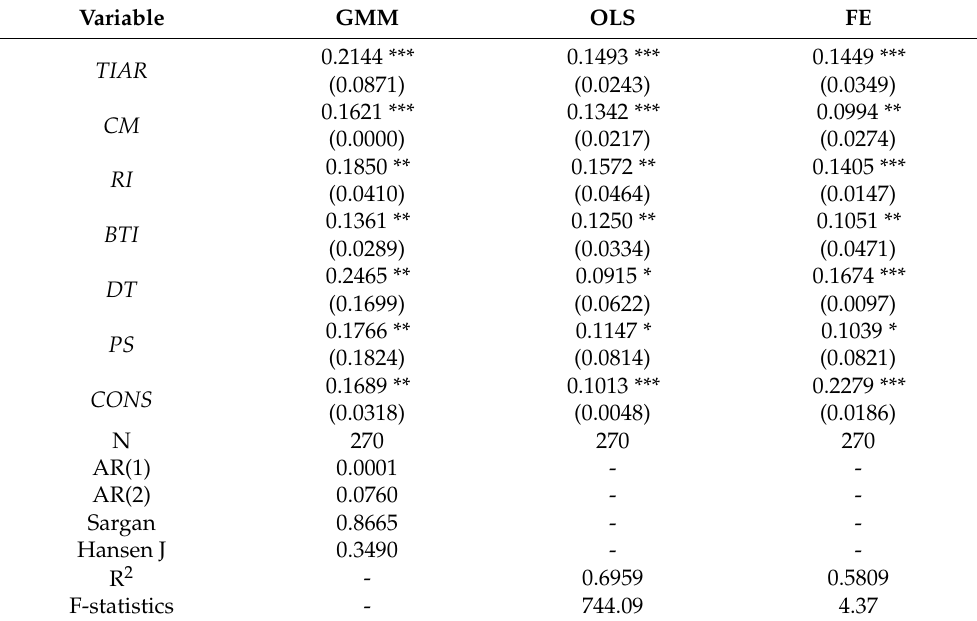
Table 5. Regression analysis